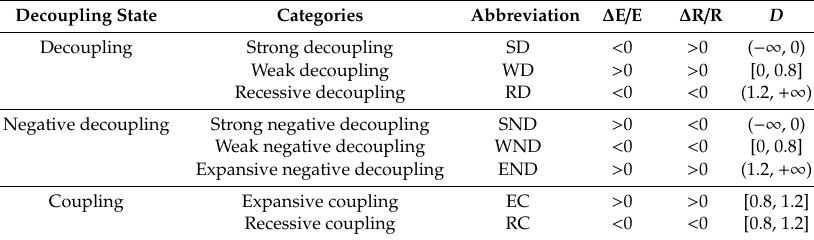
Table 1. The Tapio decoupling